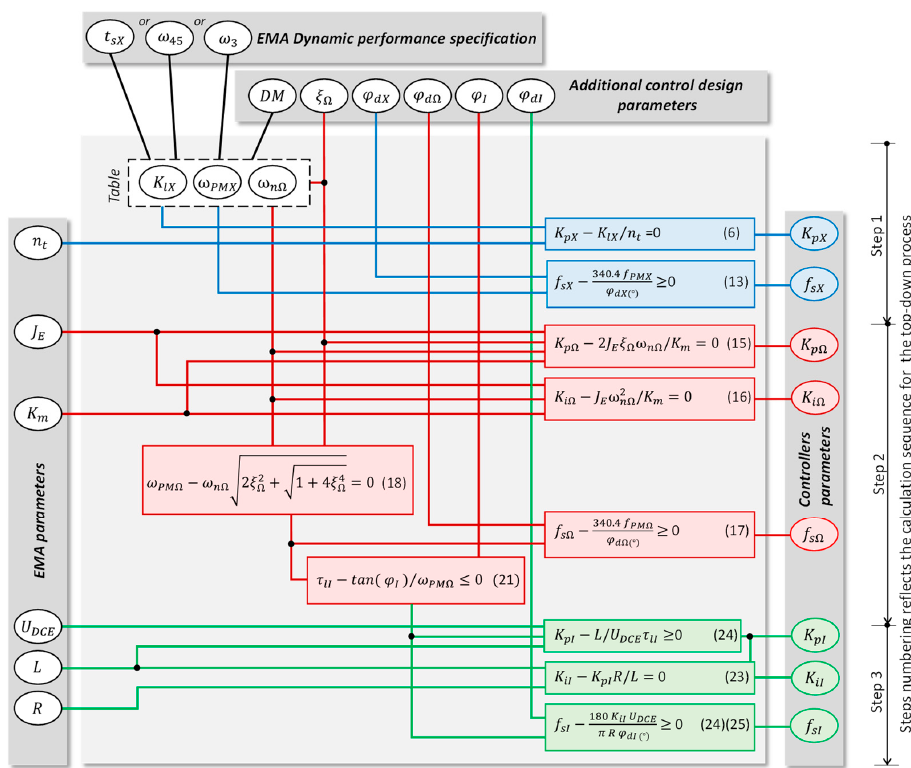
Figure 7. Noncausal representation of the interdependence among parameters for the design of the EMA position control. EMA position